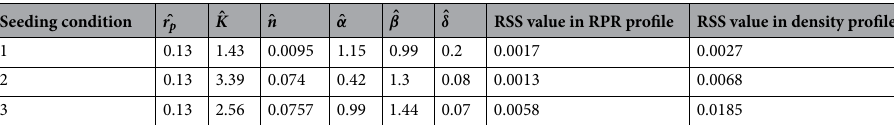
line represent the logistic time-density fit after and before 18 h density profiles respectively. The orange-colored lines in the Fig. 3 are the expected population density as per estimated parameters from the RPR fitting after 18 h data sets. Table 4 enlists all parameters for a comparison between logistic and our model fitting. Trends in cell densities under deterministic set up. The r p is fixed for a cell line among all the deter- mining parameters of the conditional MSSCD. n and K vary together with the culture media, flask, and envi- ronmental setup. On the other hand, the α , β , and δ vary together with intercellular-interactions and cellular- interaction with growth-inhibitory molecules, which depend on the medium’s initial cell density per well and fluidity. We observe that the distribution of the conditional MSSCD depends more on the K than the n . There is larger flask to achieve maximum proliferativeness. The conditional MSSCD depends more on β than α (Fig. 5a). The cells may tend to overproliferate under both